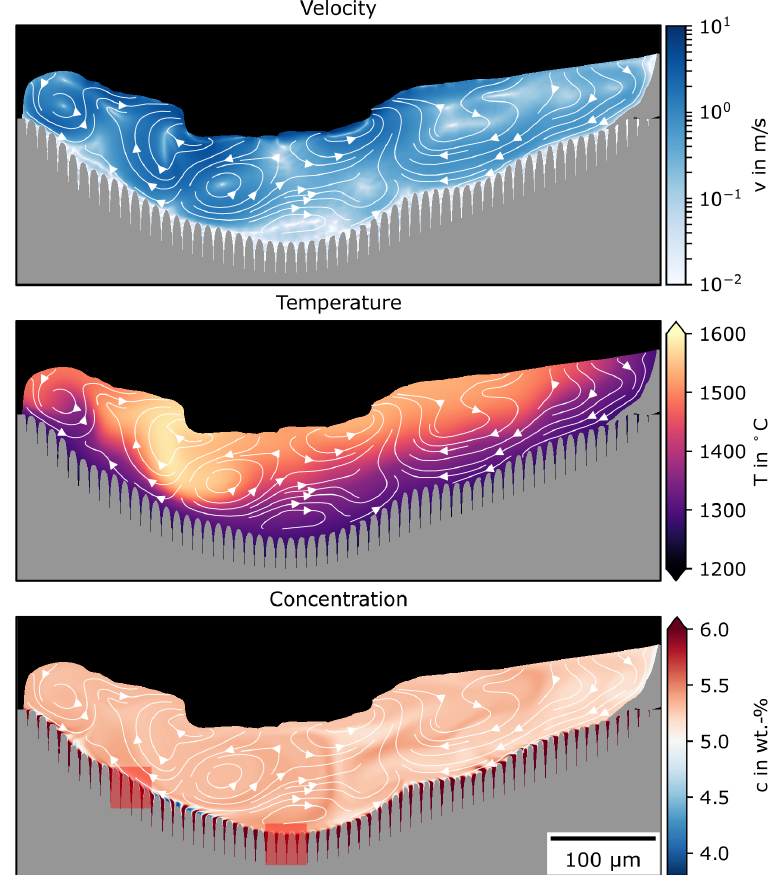
Figure 7. Simulation results of velocity, temperature, and concentration distribution when maximal melt-pool depth was reached during remelting of predefined periodical Nb composition. Stream lines show current velocity field. For the concentration field, two areas are marked for further